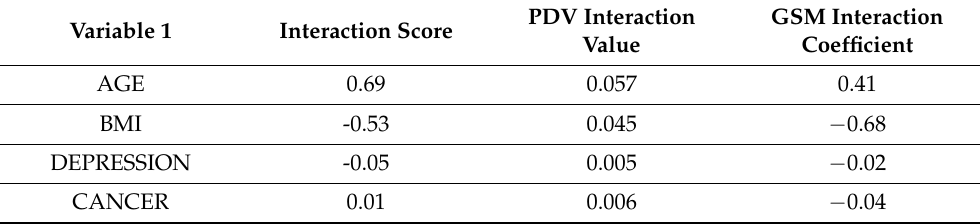
Table 8. Interaction scores, PDV interaction values and GSM interaction coefficients on four selected variable pairs. The first column is Variable 1, and Variable 2 is always the variable RACE: Black (vs.